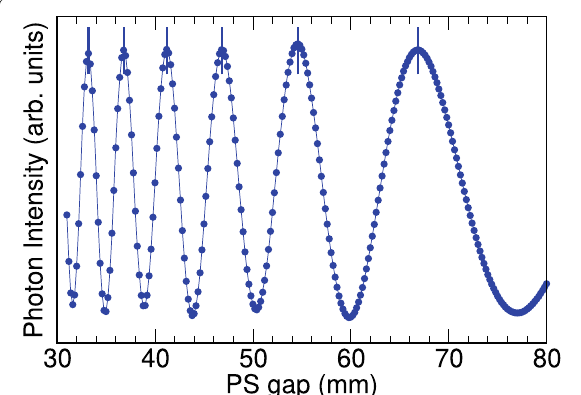
Fig. 9 Flux from ID1 and ID3 as a function of PS1 gap. The gaps of ID1 and ID3 were set to (cid:2) ω =980 eV, and the gap of PS1 was